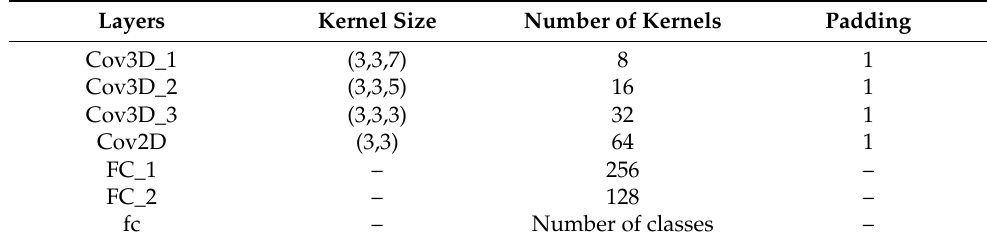
Figure 2. The network structure of TBN-MERS (Conv3D represents the cascade of 3D convolutional layer, BatchNorm layer and ReLU layer; Conv2D represents the cascade of 2D convolutional layer, BatchNorm layer and ReLU layer; FC represents the cascade of fully connected layer and dropout layer; fc represents the cascade of the fully connected layer and the Softmax layer). Table 1. The hyper-parameters of the TBN-MERS.